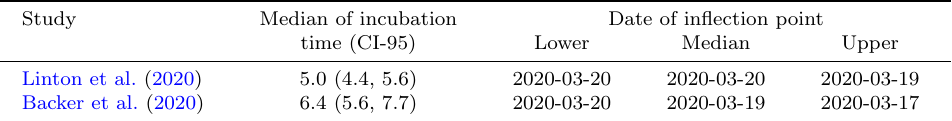
Table 5: Date of inflection point depending on assumed incubation